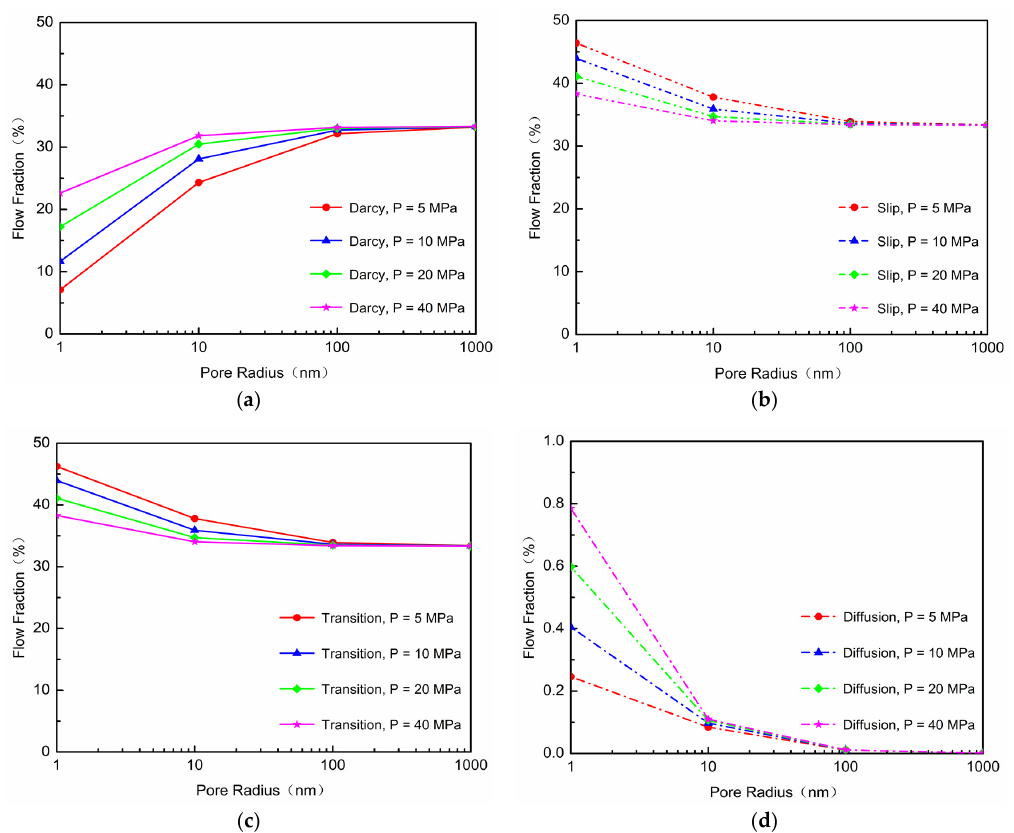
Figure 3. Gas flow fraction versus pore radius for various pressures. ( a ) The fraction of Darcy flow; ( b ) the fraction of Slip flow; ( c ) the fraction of Transition flow; and ( d ) the fraction of Diffusion flow.